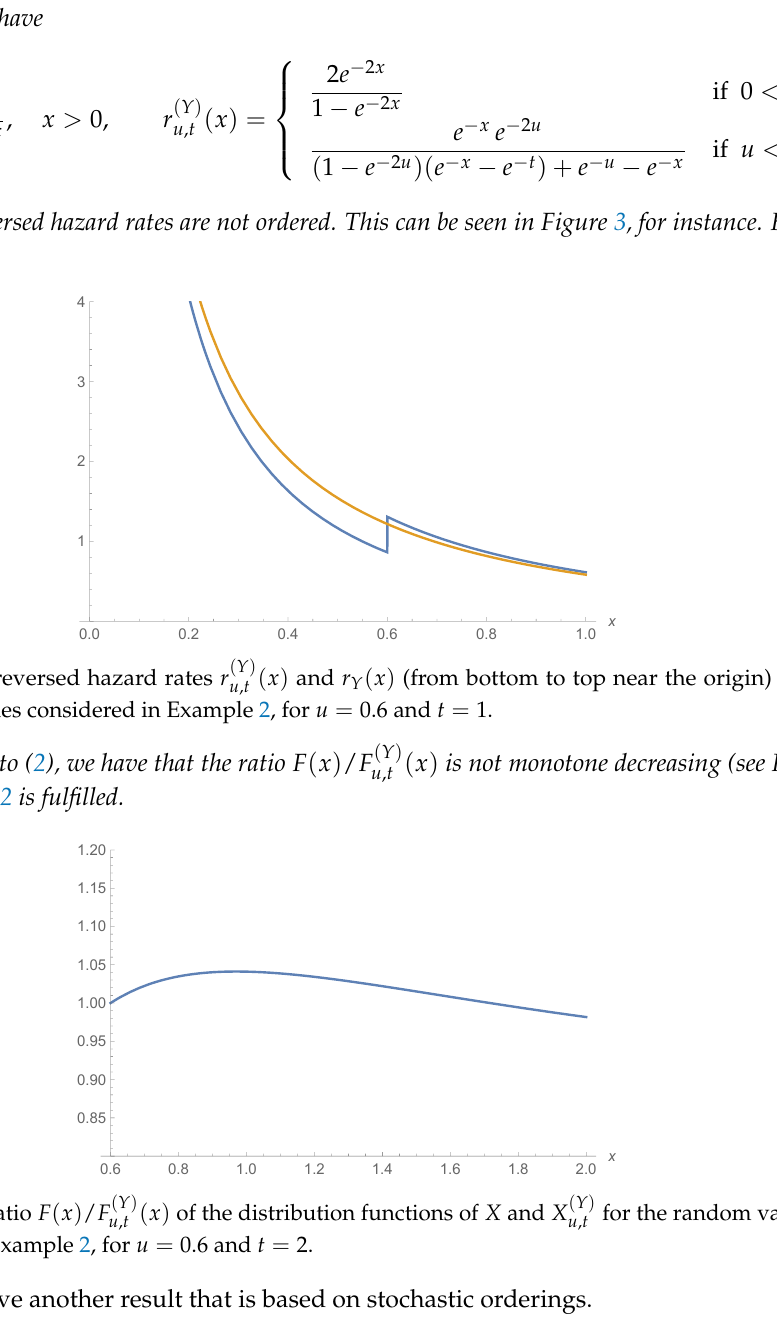
for the random variables u , t